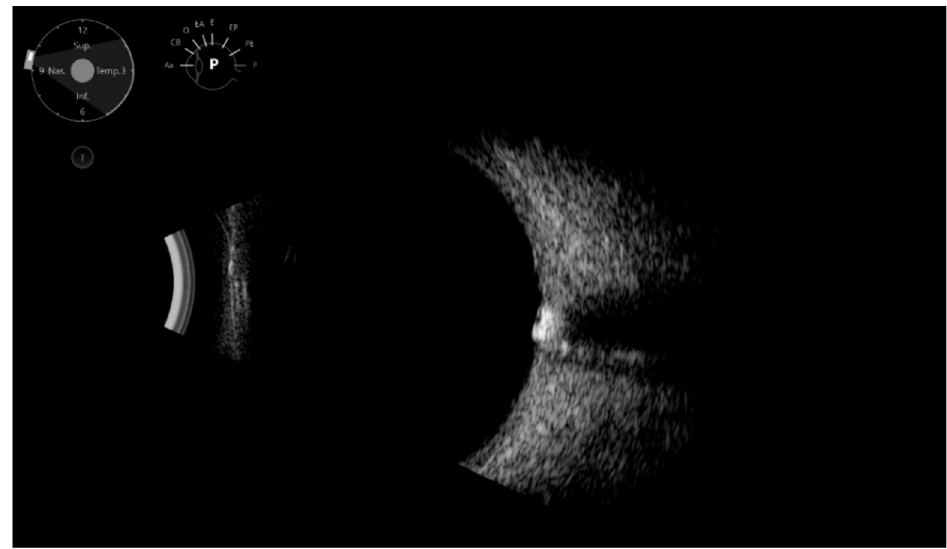
Figure 1. Ultrasound: Large optic disc drusen, visible as a highly reflective structure with posterior shadowing at the optic nerve level.